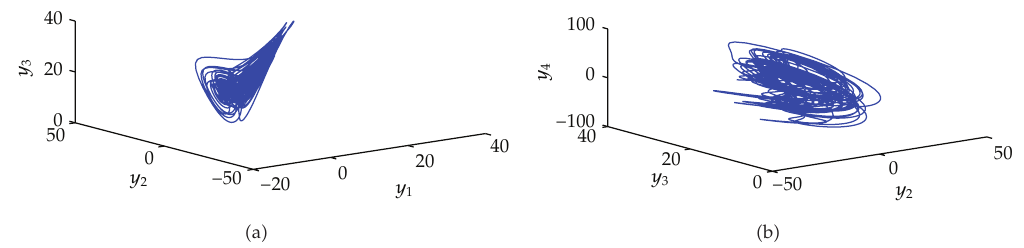
Figure 4: Hyperchaotic attractors of the fractional-order hyperchaotic Lˇu system (cid:2) 3.6 (cid:3) for q r (cid:8) 0 .